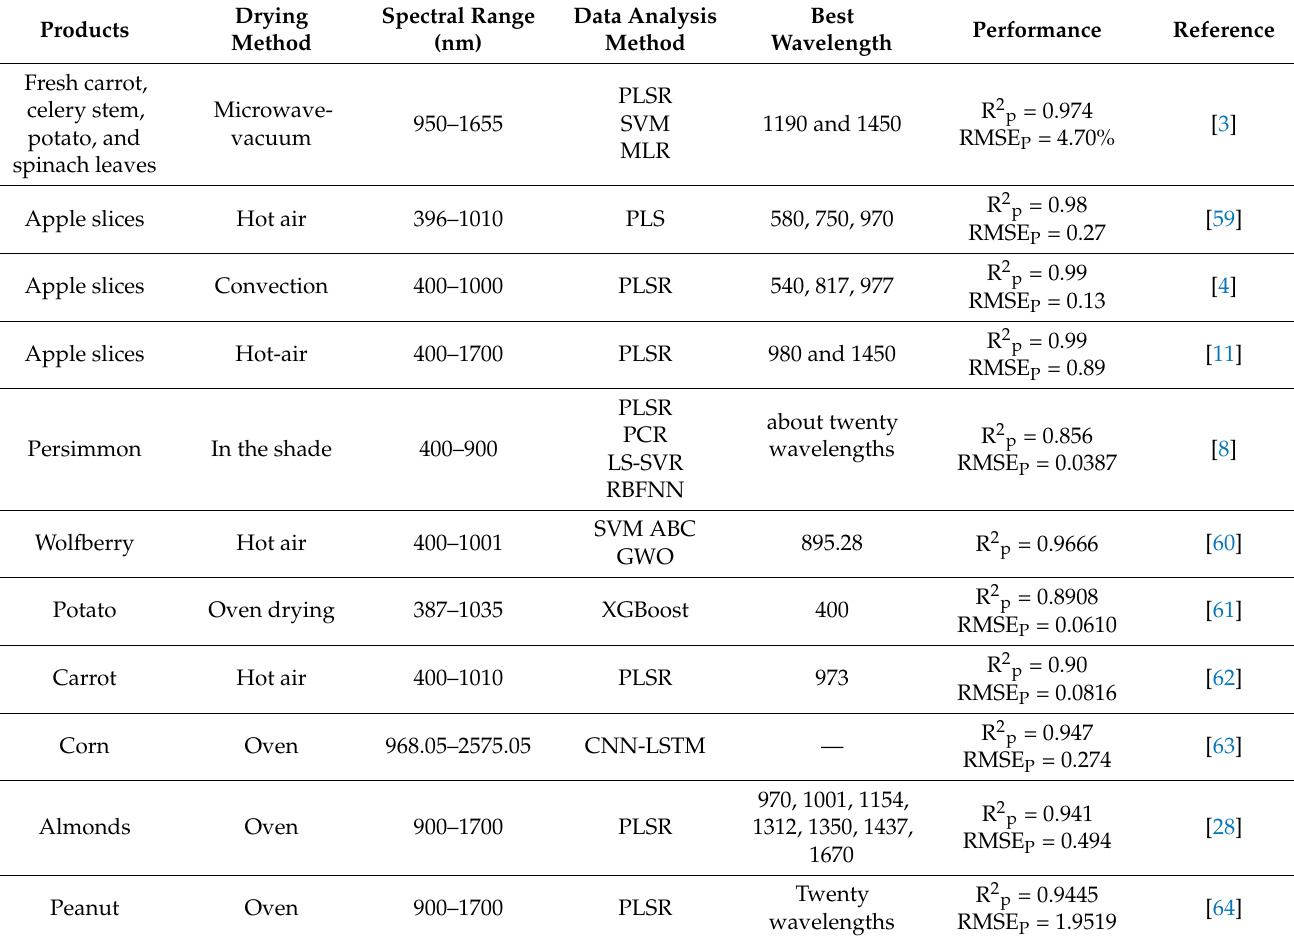
Table 2. Application of HSI for prediction of MC of agricultural products during the drying